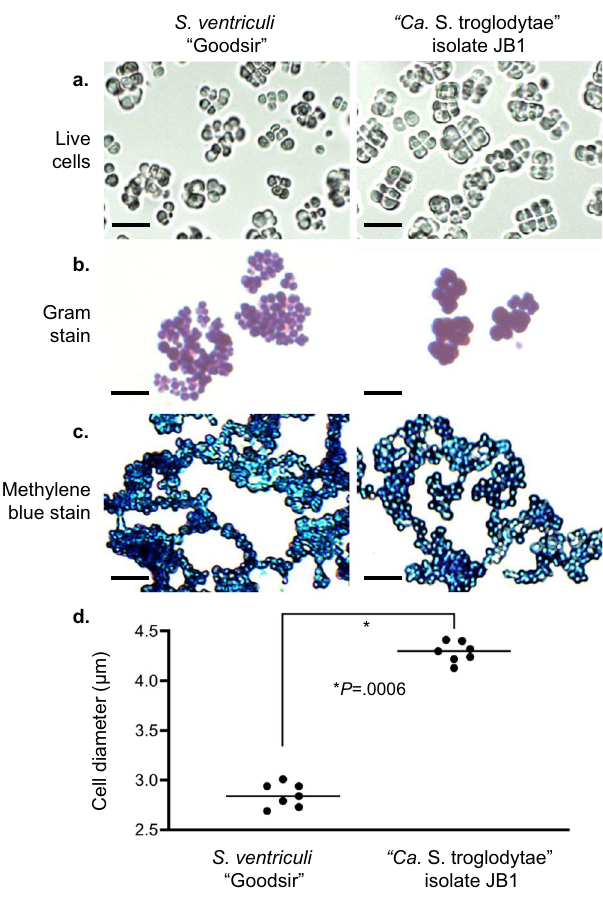
Fig. 5 Comparative morphology of type strain Sarcina ventriculi “ Goodsir ” ATCC 29068 and “ Ca . S. troglodytae ” isolate JB1. a – c Cells were imaged live ( a ) or heat- fi xed and stained with Gram stain ( b ) or methylene blue stain ( c ). Micrographs are from a single experiment and are representative of three independent experiments with similar results. Scale bars = 10 µ m. d Live cell diameters were compared, with lines representing median diameters among seven distinct bacterial colonies. Source data are provided as a Source Data fi le. *Calculated using a Mann – Whitney U test,